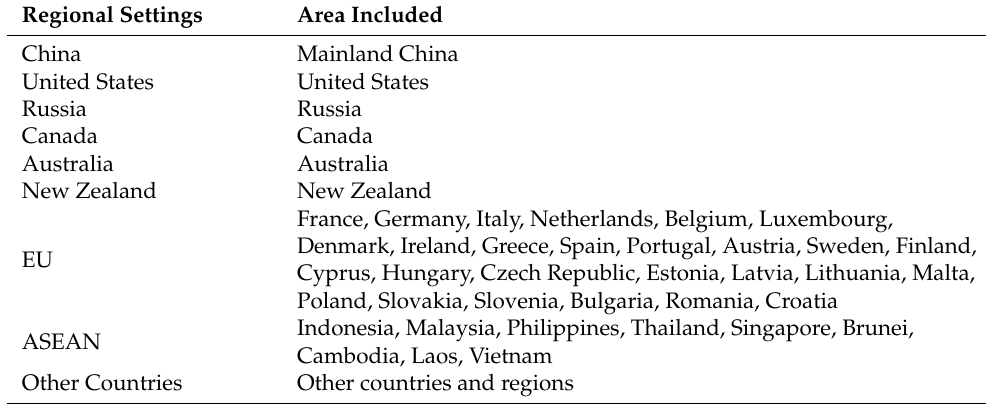
Table 1. Country (region) division.